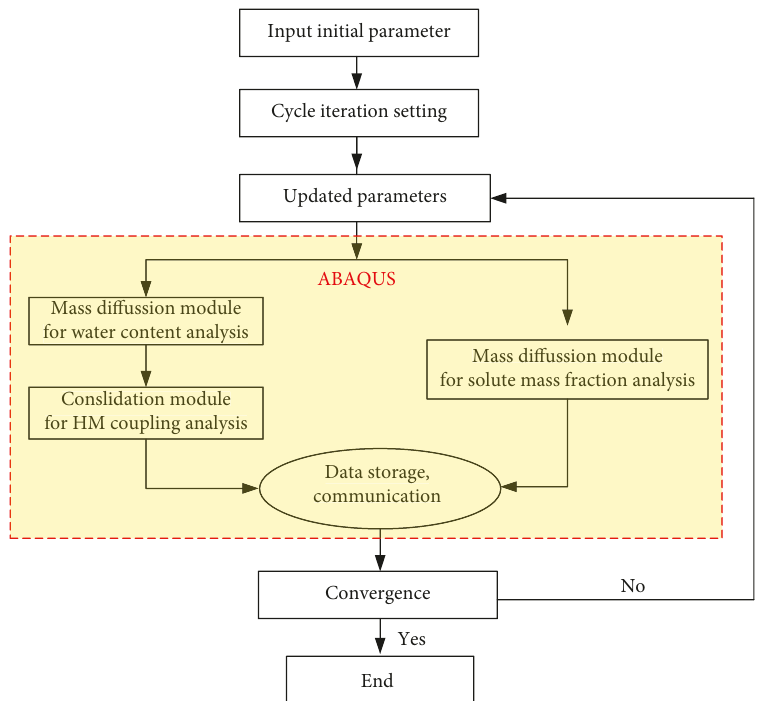
Figure 7: Flowchart of the multi fi eld coupling Table 4: Pressure tests of the Shahejie Formation. Formation Layer